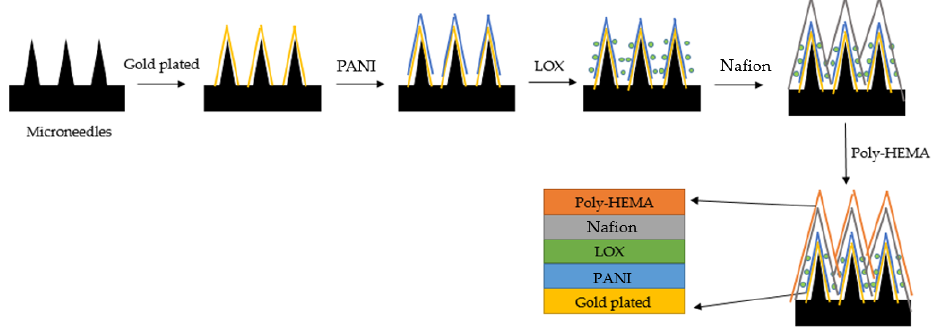
Figure 7. The schematic diagram of materials used to fabricate the percutaneous microneedle ar-